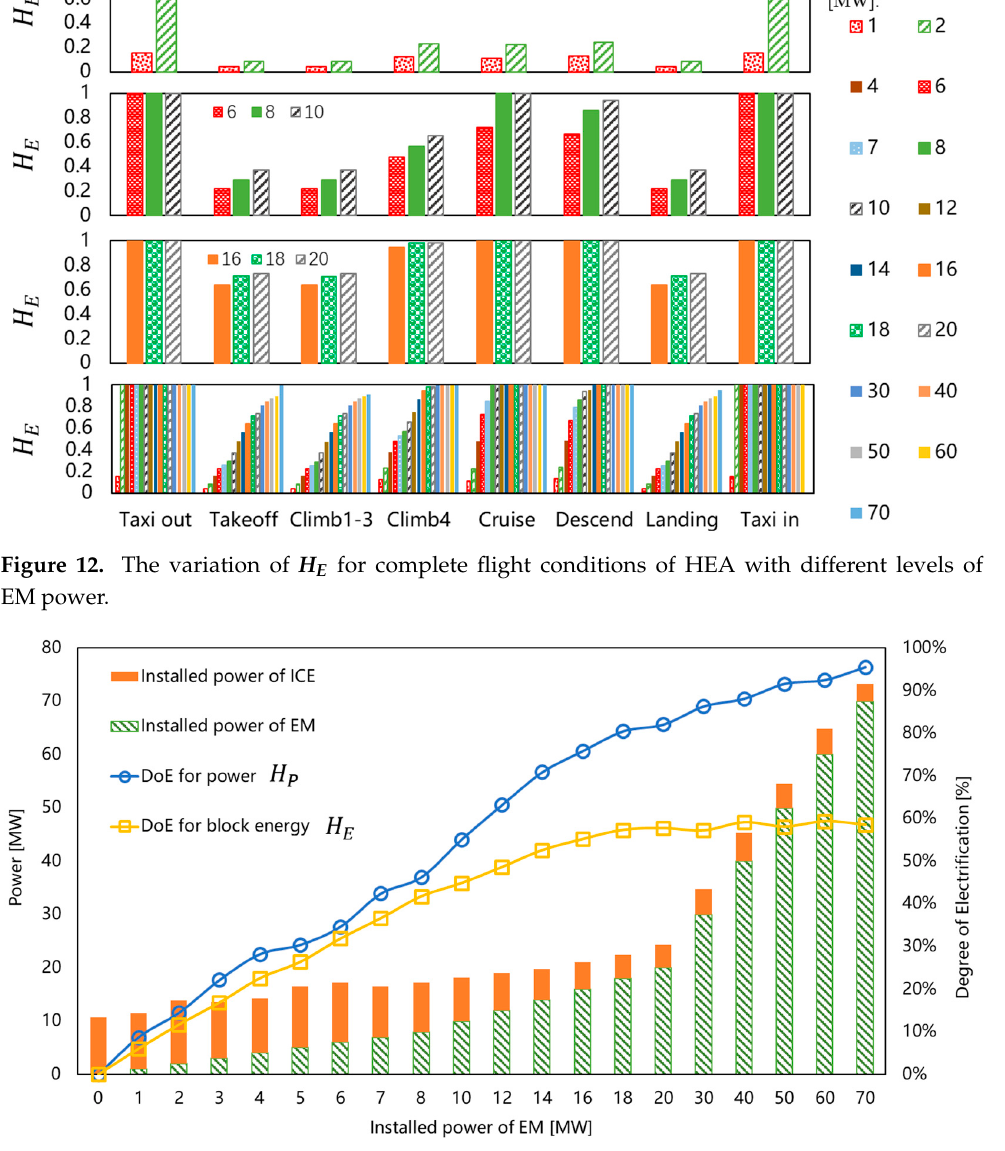
Figure 13. The variation in installed power of each power generator, 𝑯 𝑬 and 𝑯 𝑷 with different levels of EM power.